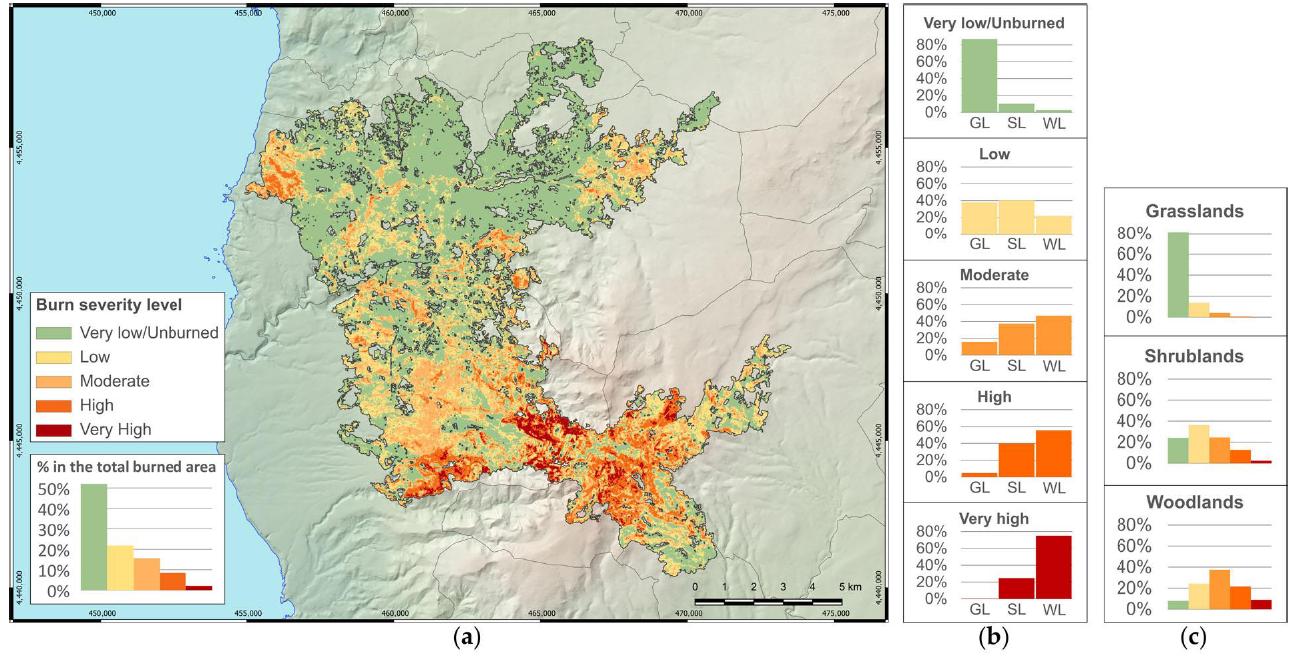
Figure 4. Burn severity one year after the fire (dNBR pre-1yr ). ( a ) Map of burn severity levels. The histogram in the map shows the percentage distribution of severity levels in the total burned area. The reference system is WGS84–UTM. ( b ) Percentage distribution of severity levels among grasslands (GL), shrublands (SL), and woodlands (WL). ( c ) Percentage distribution of severity levels within the vegetation types.